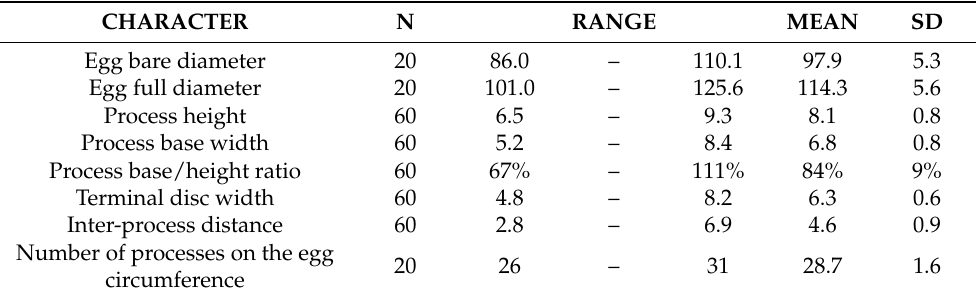
Table 3. Measurements (in µ m) of the eggs of Macrobiotus rebecchii sp. nov.; eggs mounted in Hoyer’s medium; process base/height ratio is expressed as percentage; N—number of eggs/structures measured. Range refers to the smallest and the largest structure among all measured specimens; SD—standard